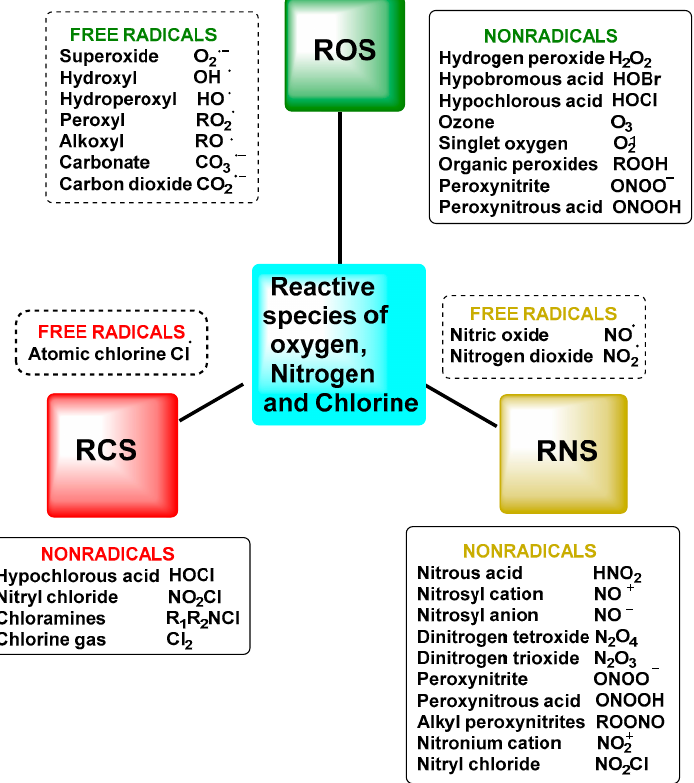
Figure 1. Nomenclature of reactive species and free radicals and other reactive oxygen, nitrogen and chlorine species.